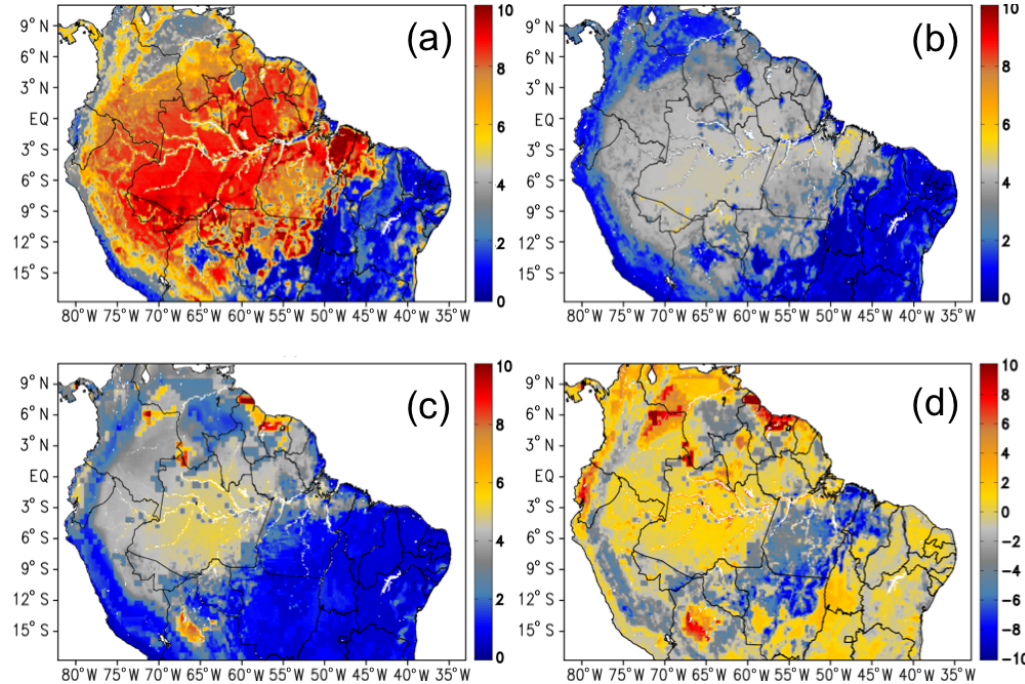
Figure 14. CO 2 fluxes as simulated by BRAMS (µmolCm − 2 s − 1 ), average for September 2010. (a) Gross primary production, (b) plant respiration, (c) soil respiration, and (d) net ecosystem exchange. A positive value means CO 2 flux from the atmosphere to the land